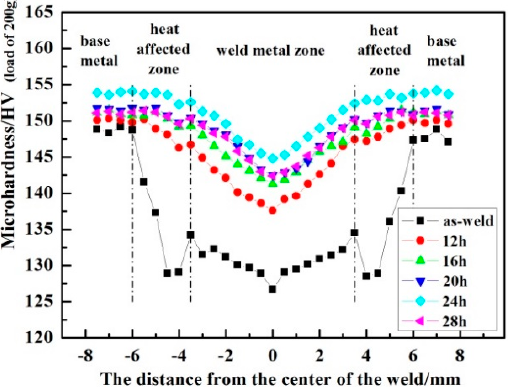
Figure 7. Microhardness distributions of welded joints aged at 130 °C for different times.